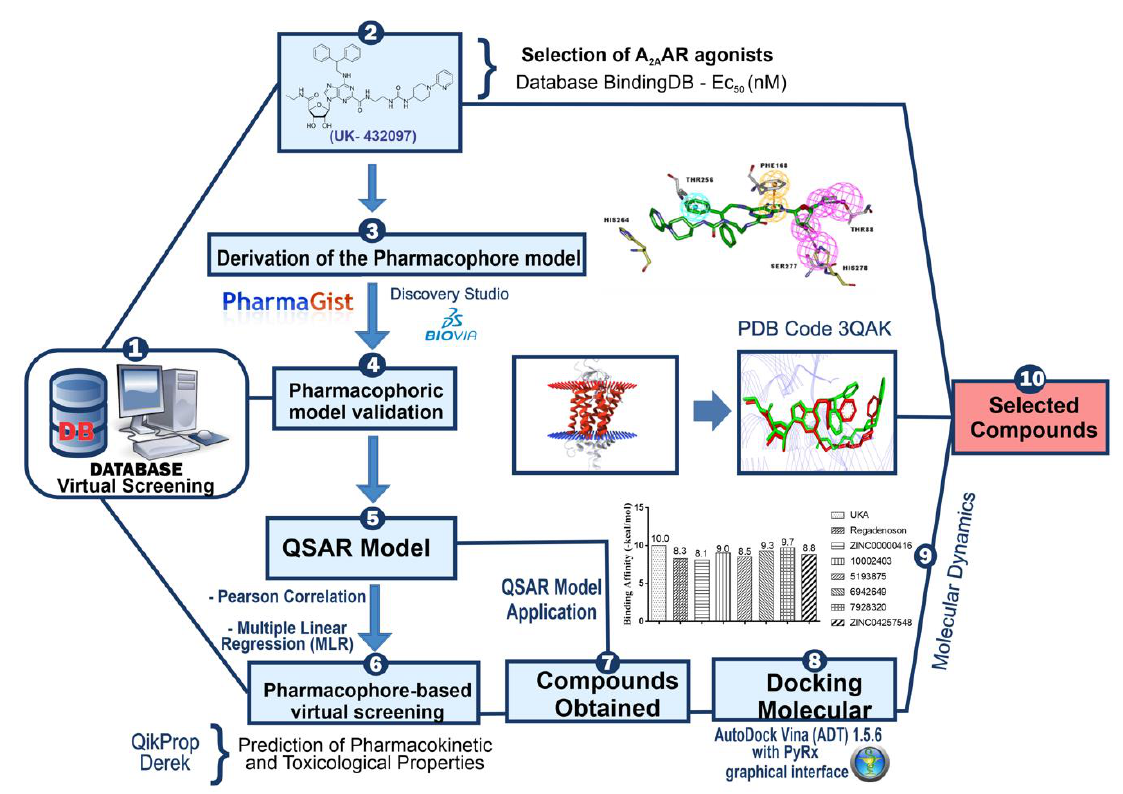
Figure 1. General scheme summarizing of the methodological steps.